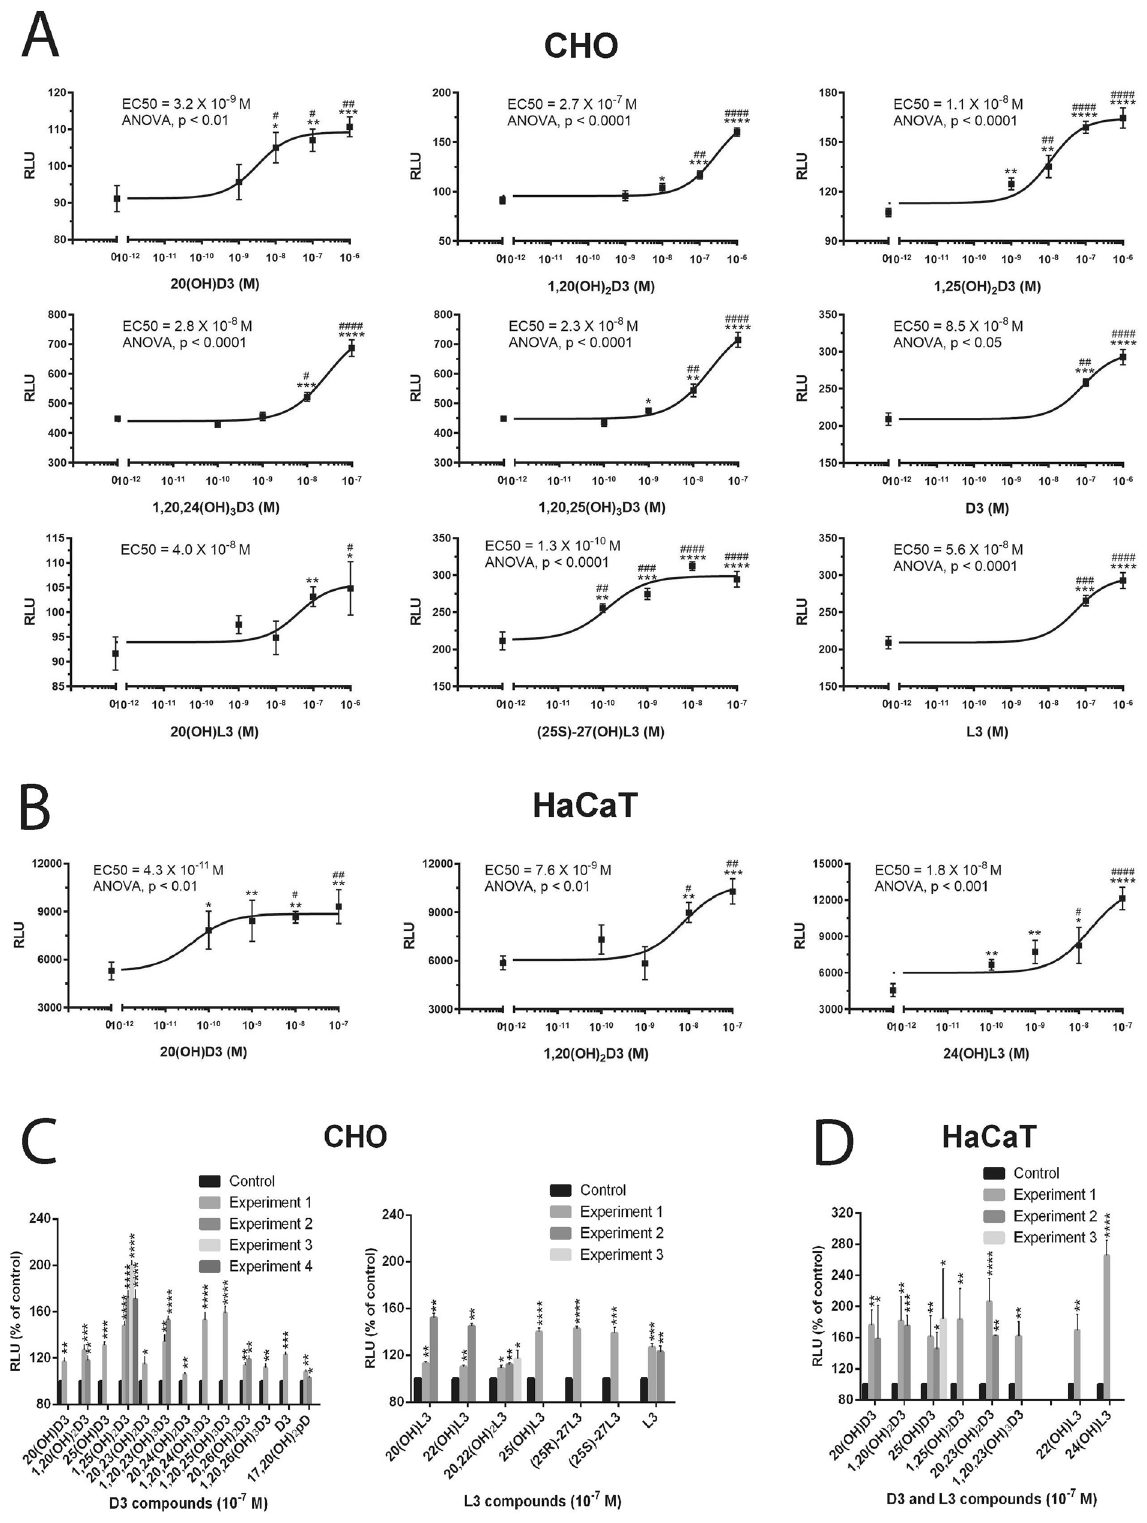
Figure 4. L3 and D3-derivatives activate a LXR-response element (LXRE)-driven reporter in CHO cells ( A , C ) and human HaCaT keratinocytes ( B , D ). Representative dose response curves are in ( A ) and ( B ), while a summary of assays performed with 10 –7 M ligands is presented for each experiment separately for CHO cells ( C ) and HaCaT keratinocytes ( D ). Data are presented as means ± SE, (n = number of assays). Analysis was done using one-way ANOVA for dose responses and the t-test: *p < 0.05, **p < 0.01, ***p < 0.001 or ****p < 0.0001 versus control